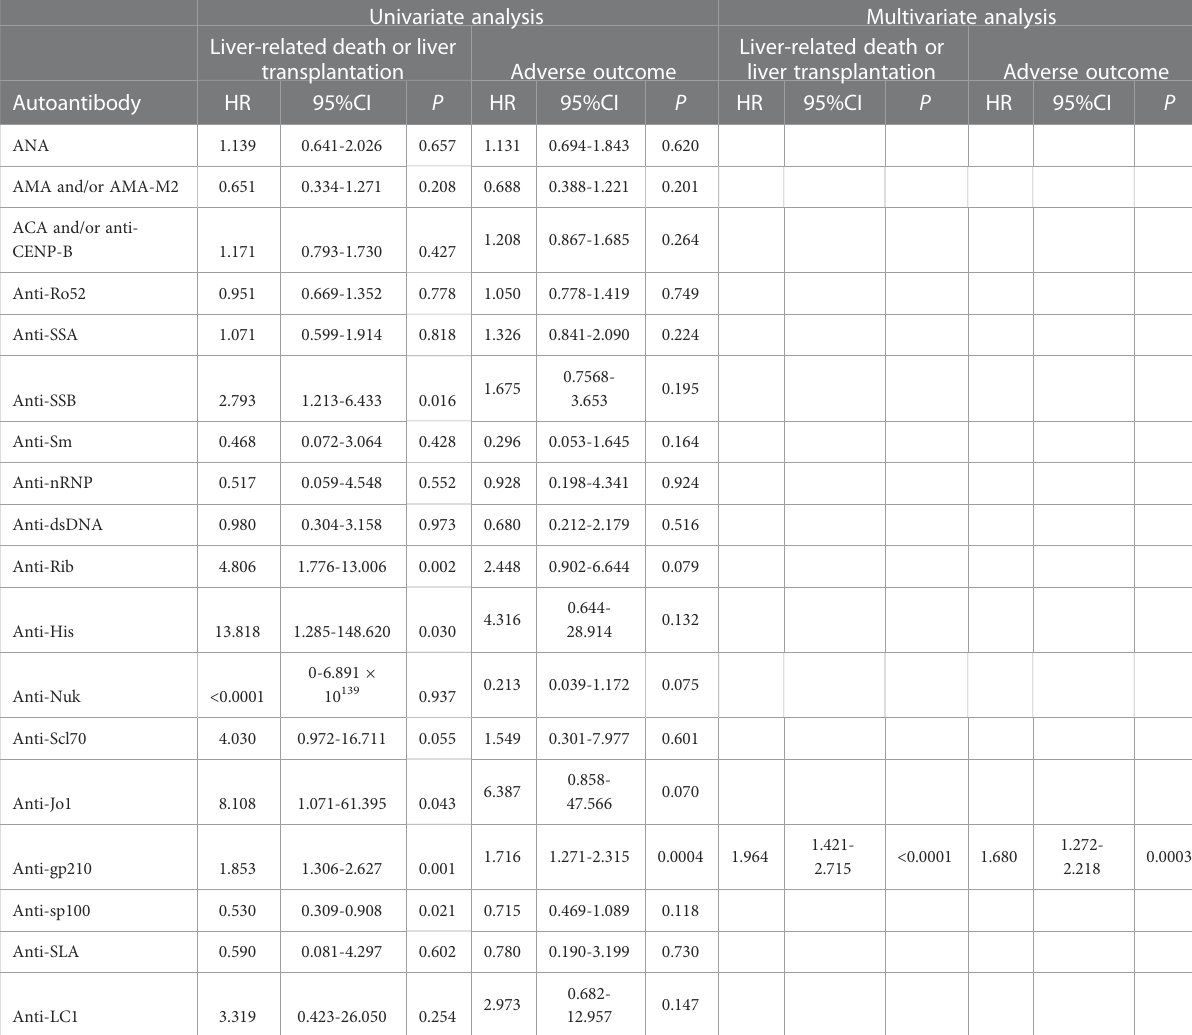
TABLE 5 Risk of of autoantibodies associated with liver-related death or liver transplantation, and adverse outcome in patients with